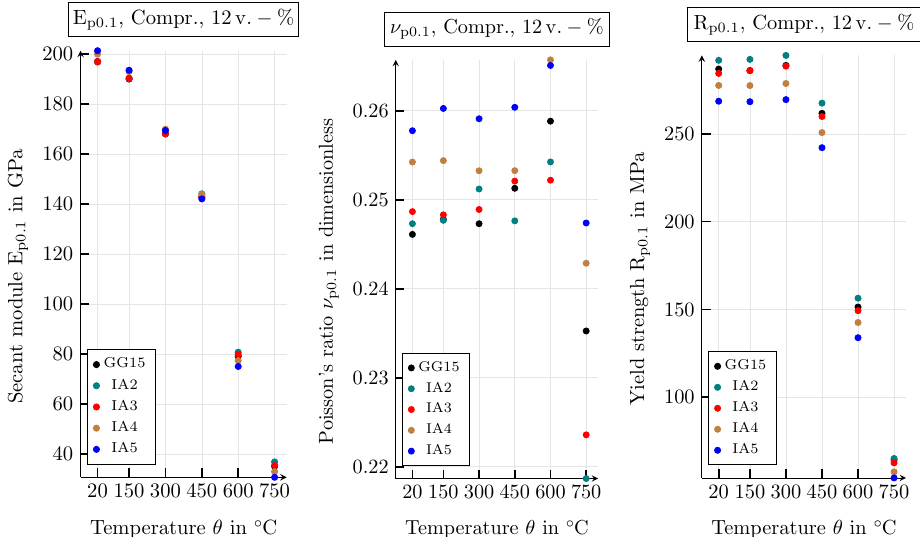
Figure 28. Secant moduli, Poisson’s ratios and yield strengths of all graphite classes with a graphite flake volume fraction of 12v. %, evaluated for temperatures 20, 150, 300, 450, 600 and 750°C, at a − compressive strain of 0.1%.